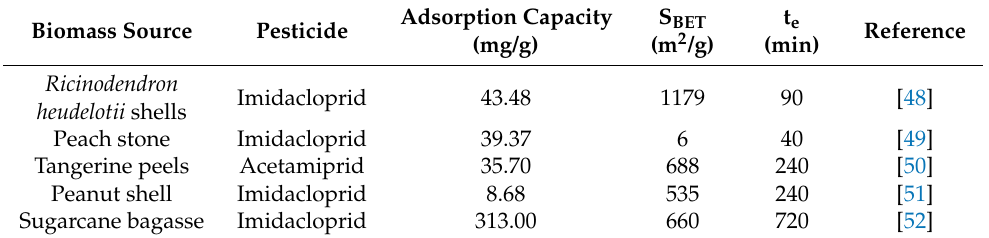
Table 7. Adsorption capacity values of pesticides onto adsorbents derived from